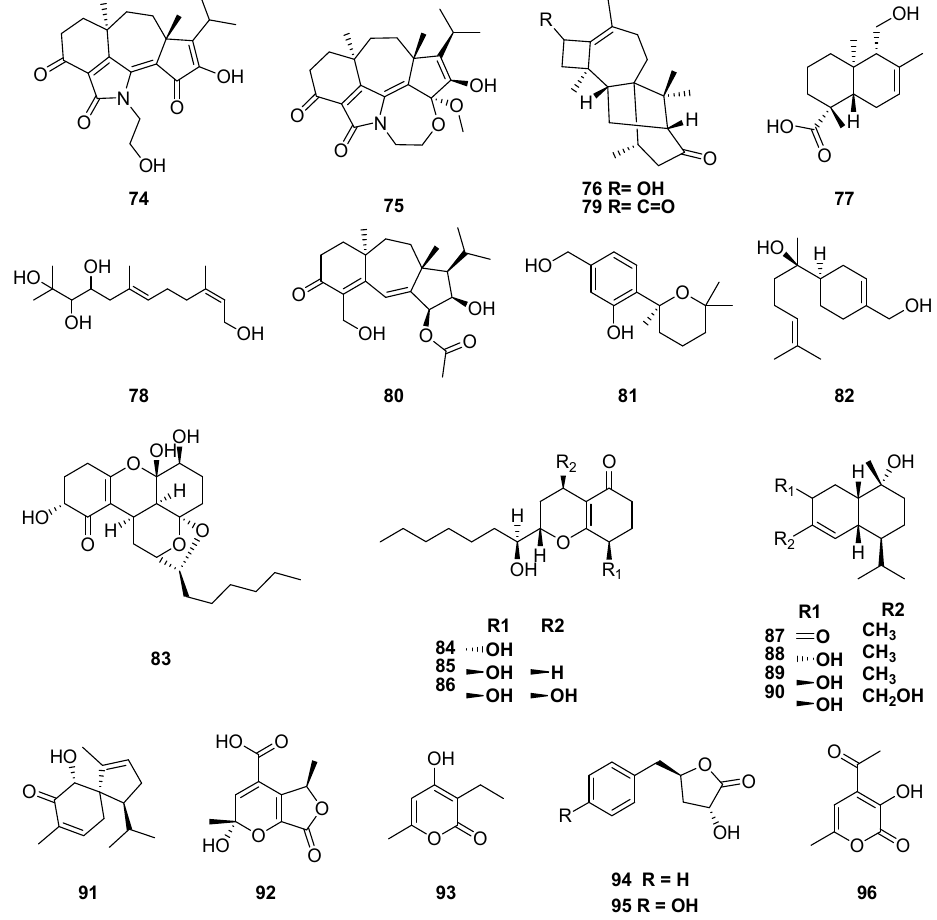
Figure 8. Compounds extracted from endophytic fungus Trichoderma koningiopsis (Hypocreaceae), also isolated from M. officinalis.